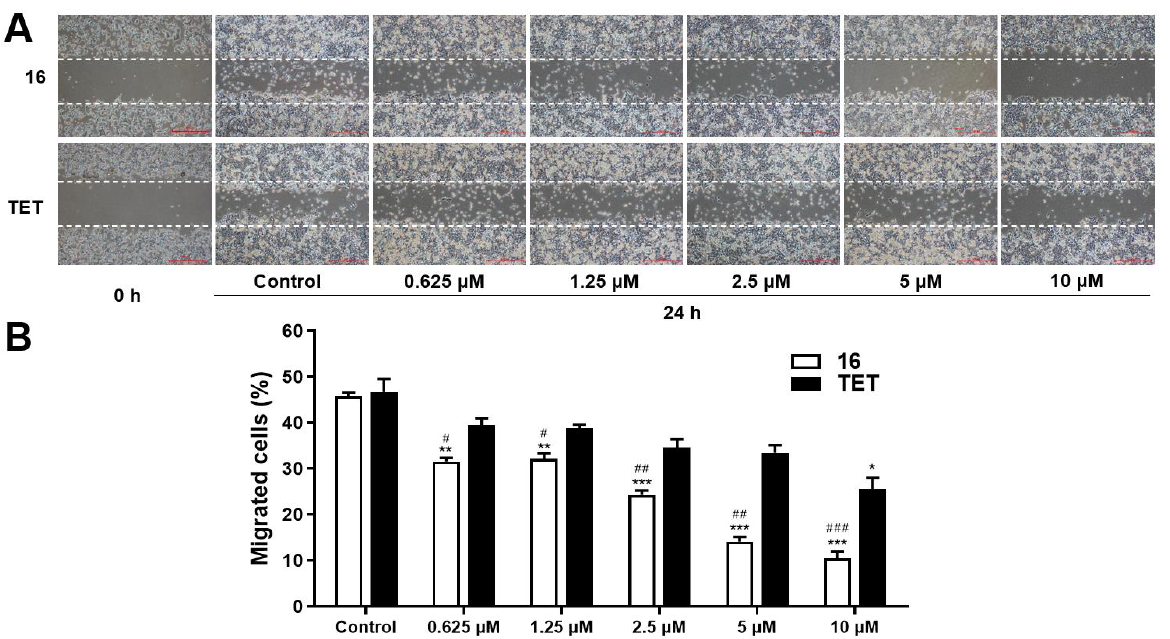
Figure 4. Effect of 16 on the migration of HCT-15 cells determined by wound healing assay. ( A ) Images of HCT-15 cell migration inhibited by 16 (0.625 1.25, 2.5, 5, and 10 μ M). ( B ) Filled areas calculated by ImageJ software. *: p < 0.05, **: p < 0.01, ***: p < 0.001 vs. control group; # : p < 0.05, ## : p < 0.01, ### : p < 0.001 vs. TET at the same concentration.